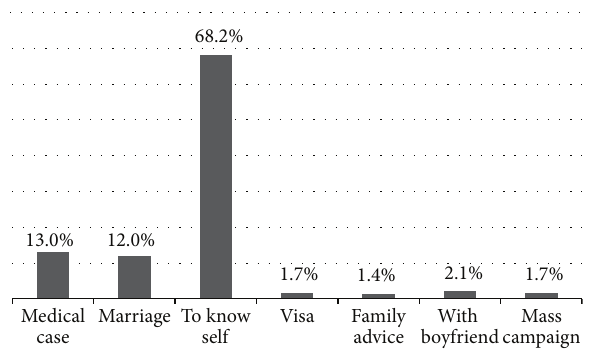
Figure 3: Reasons why they got VCT service before, BDU, April